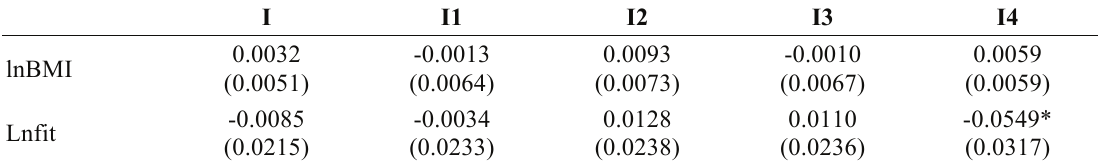
Table 4. Robustness test – estimated health effect of the interventions on a reduced sample I I1 I2 I3 I4 lnBMI